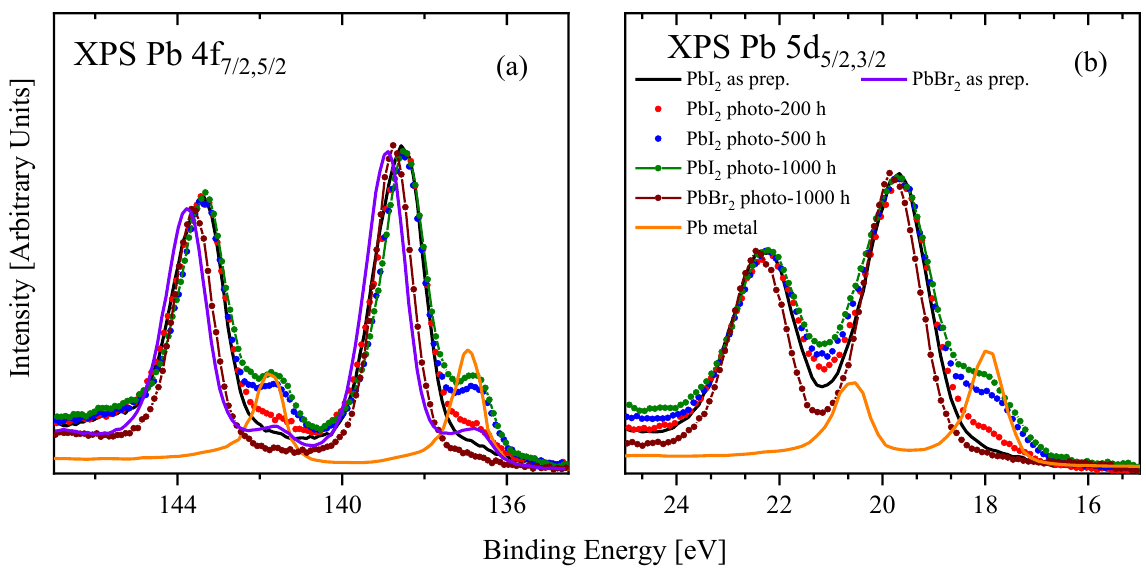
Figure 4. The comparison of high-energy resolved XPS Pb 4f 7/2,5/2 ( a ) and Pb5d 5/2,3/2 ( b ) spectra of light-soaked halides and Pb-metal.